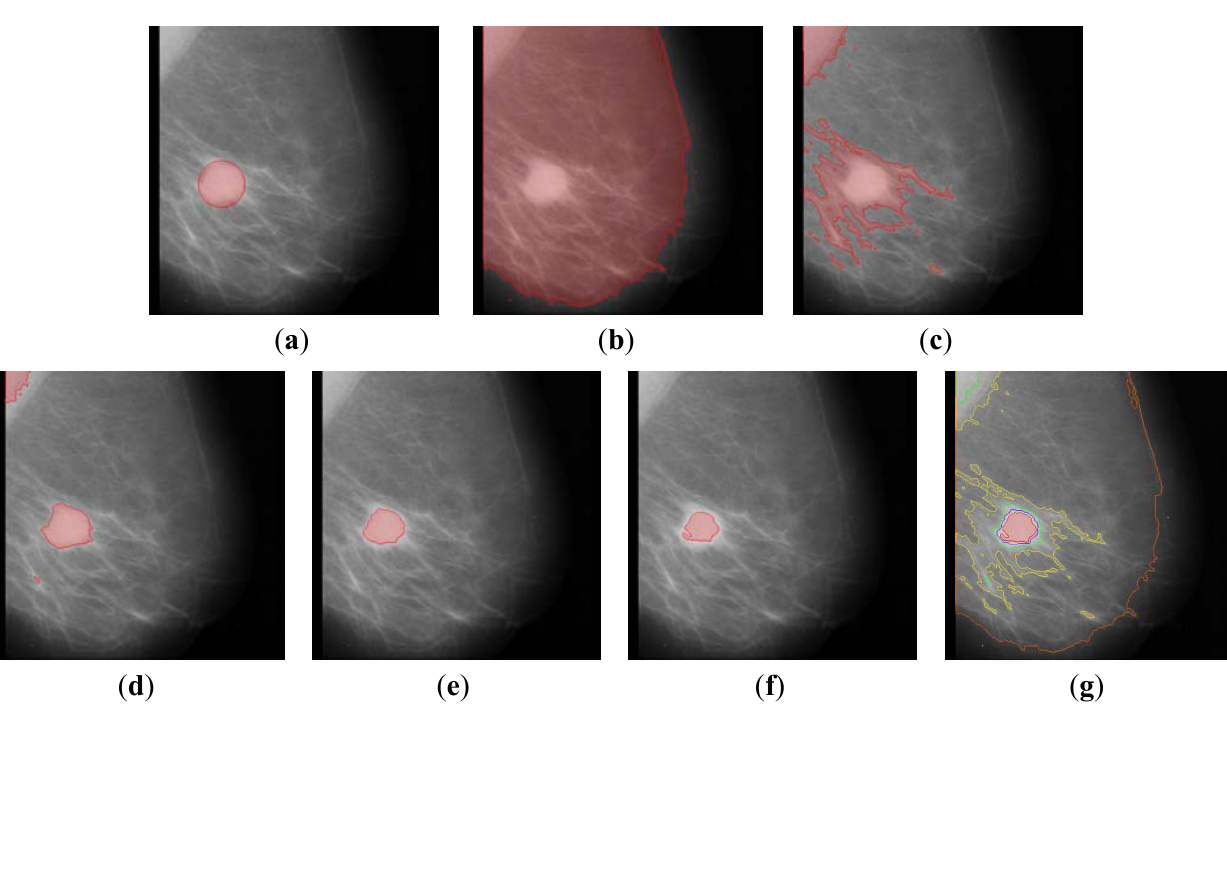
Figure 4. The mini-MIAS database of mammogram number 028. ( a ) The approximated region of abnormality from the database. ( b ) Contour 1 after 9 iterations of (14). ( c ) Contour 2 after 7 iterations. ( d ) Contour 3 after 7 iterations. ( e ) Contour 4 after 12 iterations. ( f ) Last contour 5 after 17 iterations. ( g ) Final contour